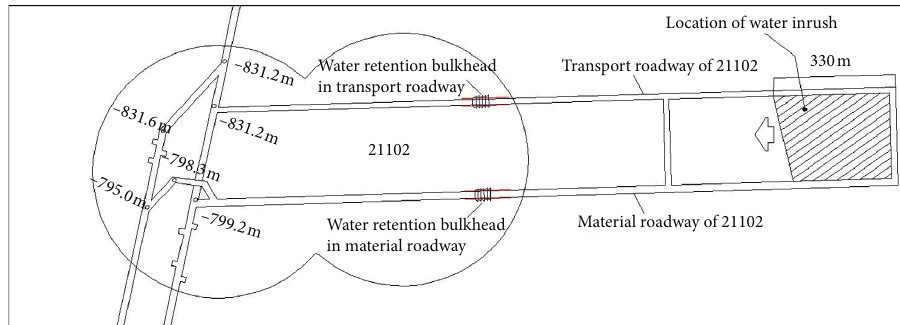
Figure 3: Schematic plan view of locations of water retention bulkheads in Sanhejian coal mine.